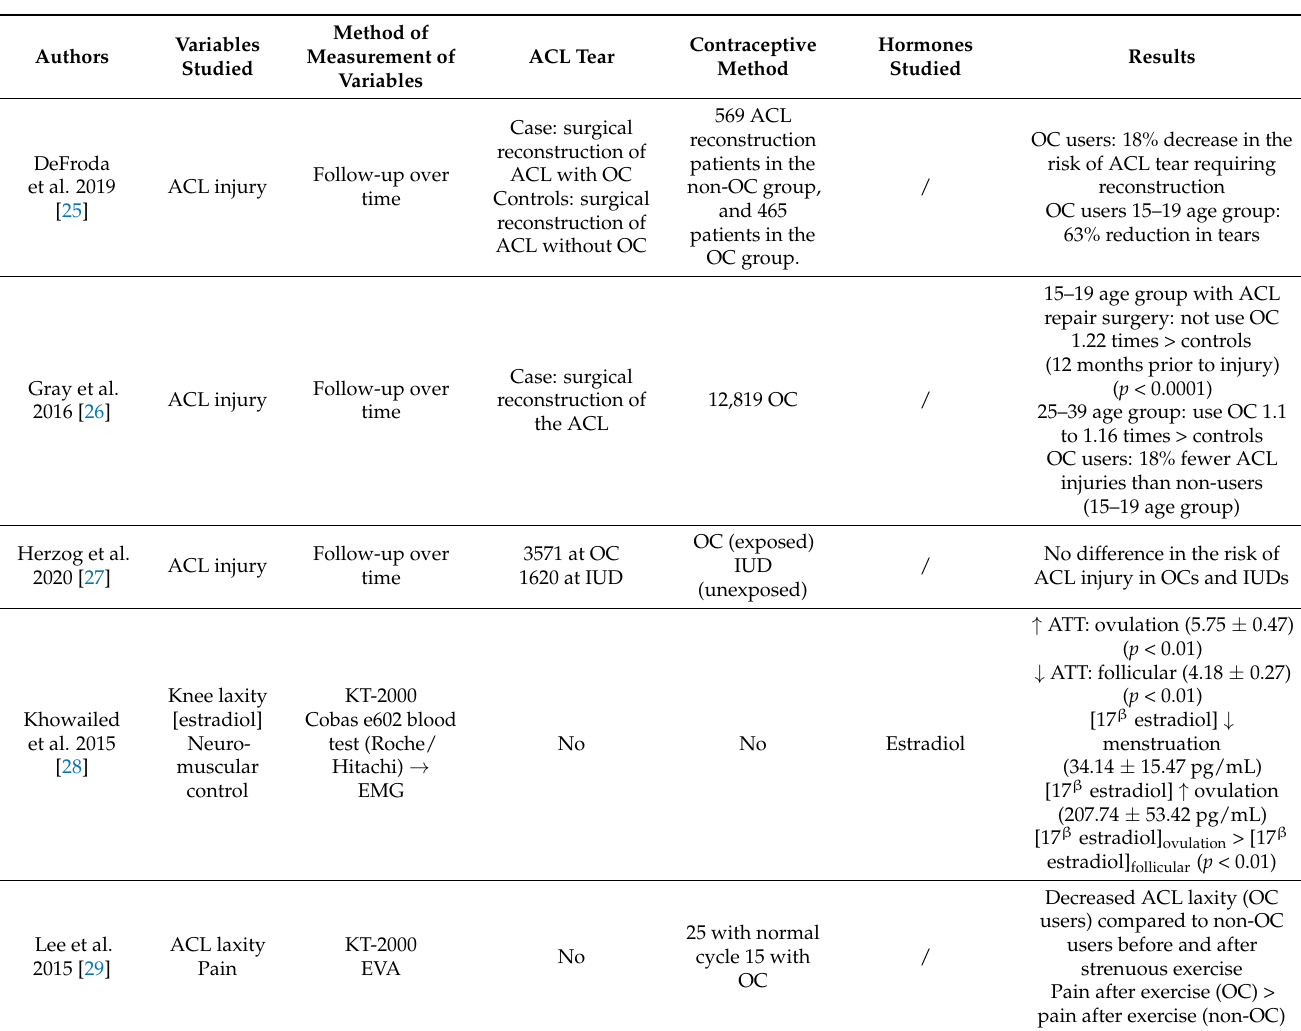
Table 2. Summary of included